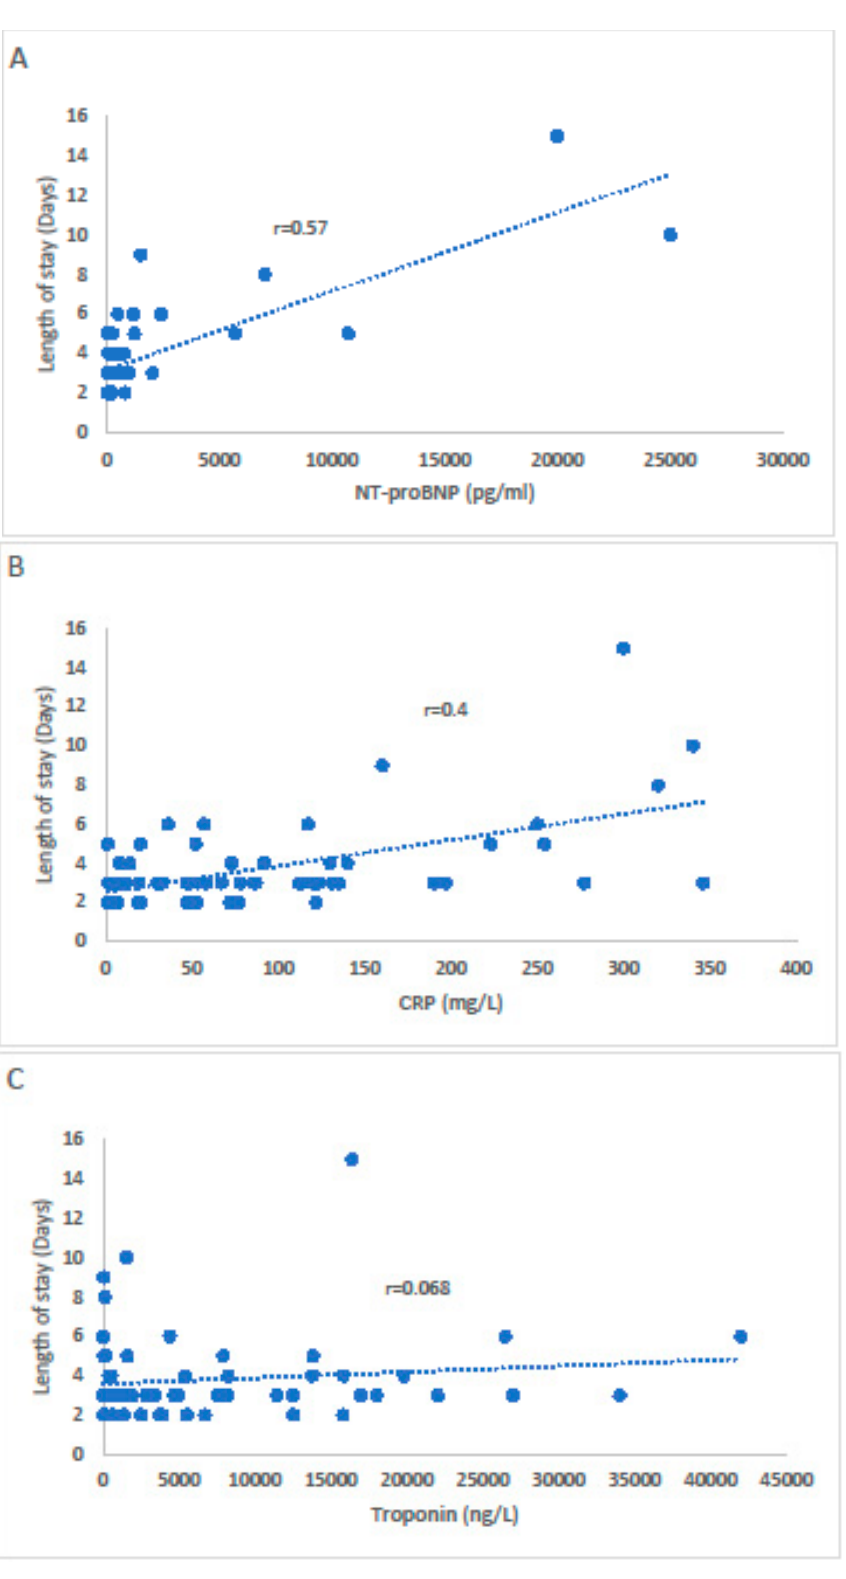
Figure 2. The correlation between NT-proBNP ( A ), CRP ( B ), and troponin ( C ) with the length of stay. A statistically significant correlation was observed between NT-proBNP (A), CRP (B) and the length of stay, while there was no correlation with troponin level (C).